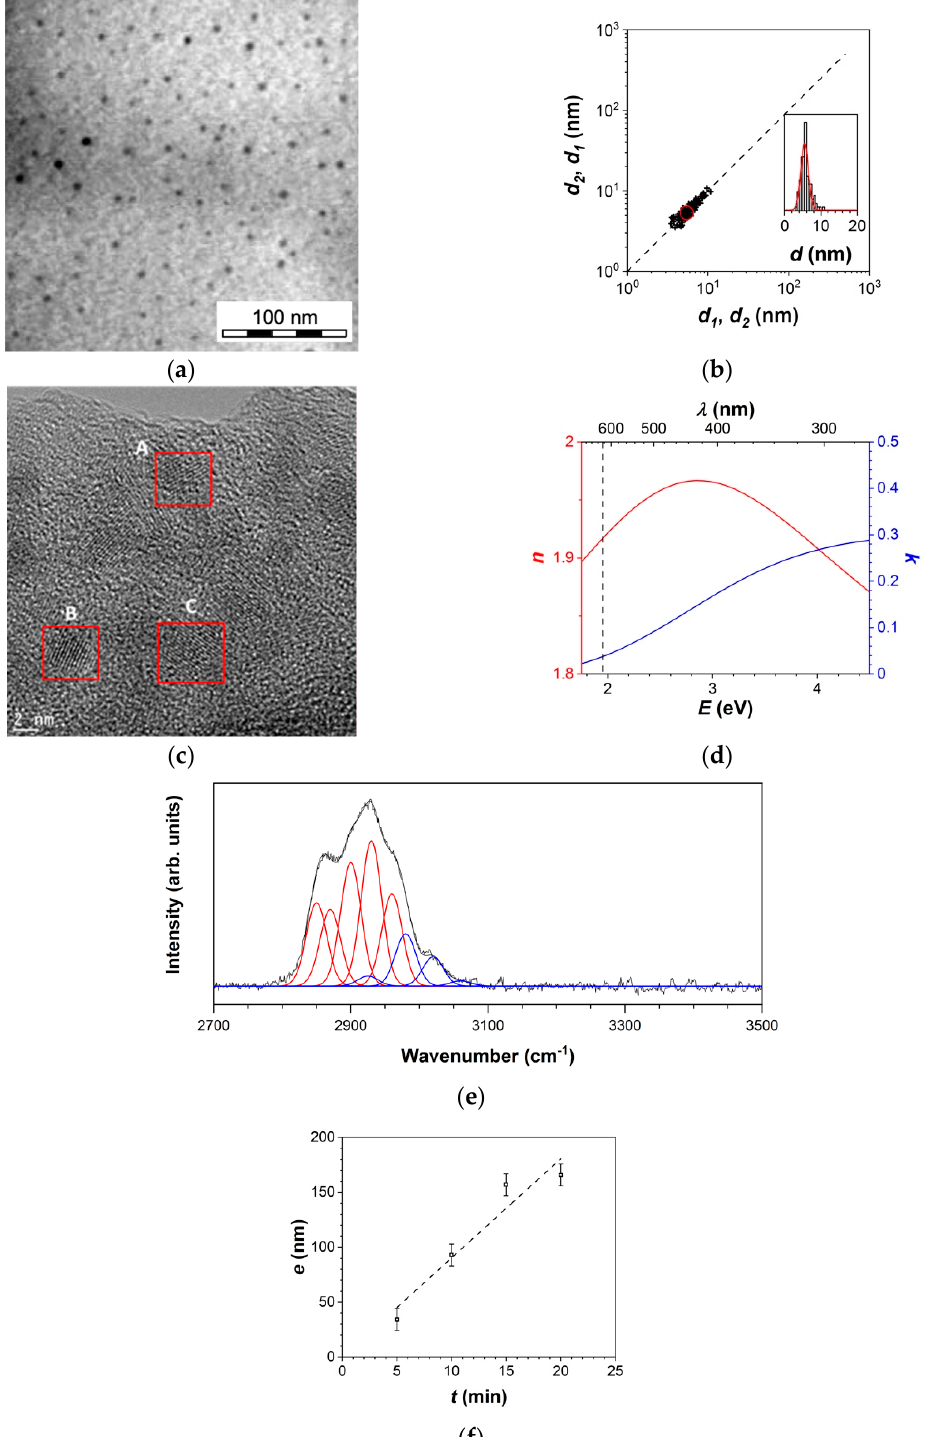
Figure 2. Characteristics of the coatings obtained with DLRI into an asymmetric low-pressure RF discharge ( t liq = 5 ms, t gas = 10 ms, Δ t = 2 ms, f = 1 Hz, deposition time 10 min): ( a ) TEM image ( b ) and ( c ) HRTEM image ( d ) optical indexes spectra and ( e ) IR spectrum in the 2700–3500 cm − 1 range. In ( f